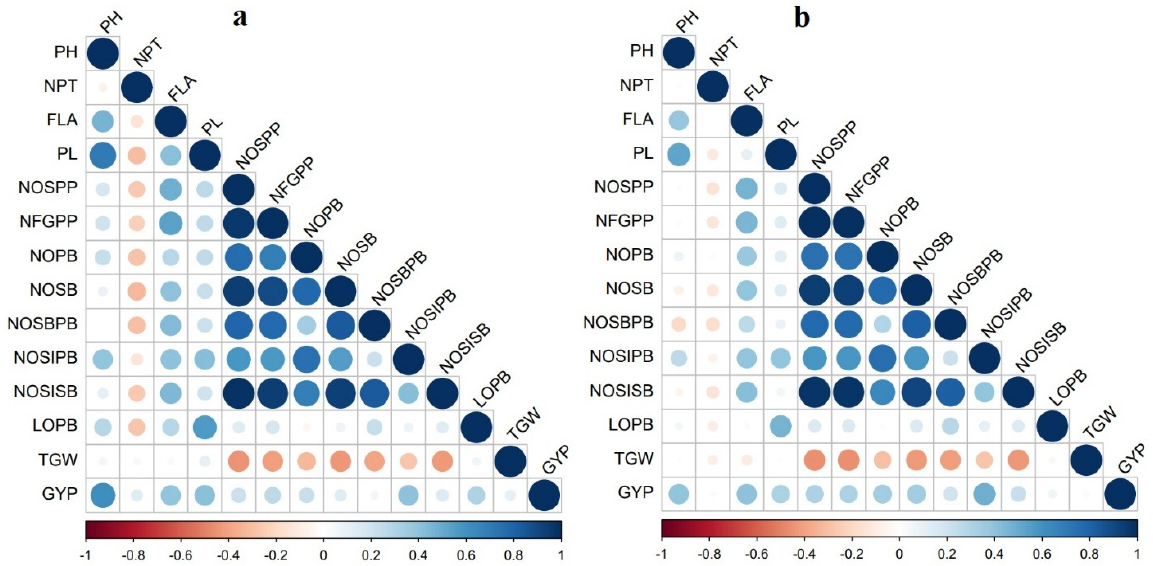
Figure 3. Pearson’s correlation matrix for the panicle- and yield-related traits studied during ( a ) rabi